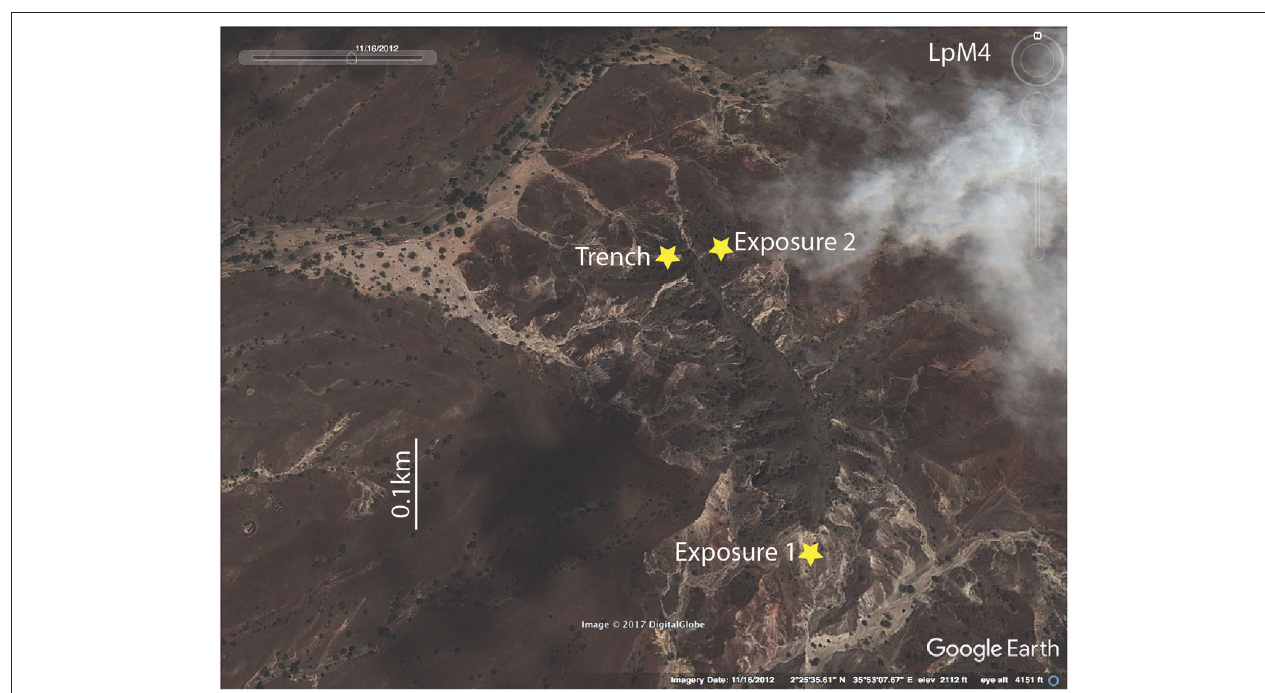
FIGURE 3 | Location of fossil-bearing sites at Loperot’s site LpM4. Satellite image of exposures that were excavated, measured, and described (Trench) as well as those that were only described from outcrop (Exposure 1, and Exposure 2). (Map data © 2017 Digital Globe: “LpM4.” 22 ◦ 5 ′ 35.81 ′′ N 35 ◦ 53 ′ 7.67 ′′ E. DigitalGlobe, GoogleEarth.